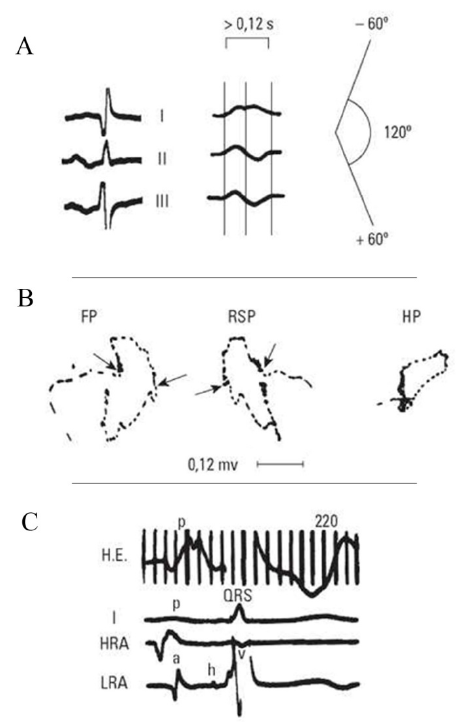
Figure 4. Typical ECG of advanced interatrial block (P-wave ± in leads II, III, and aVF and duration ≥ 120 ms) in a patient with ischemic heart disease. When amplified (left) we can see the beginning and the end of the P-wave in the three leads.